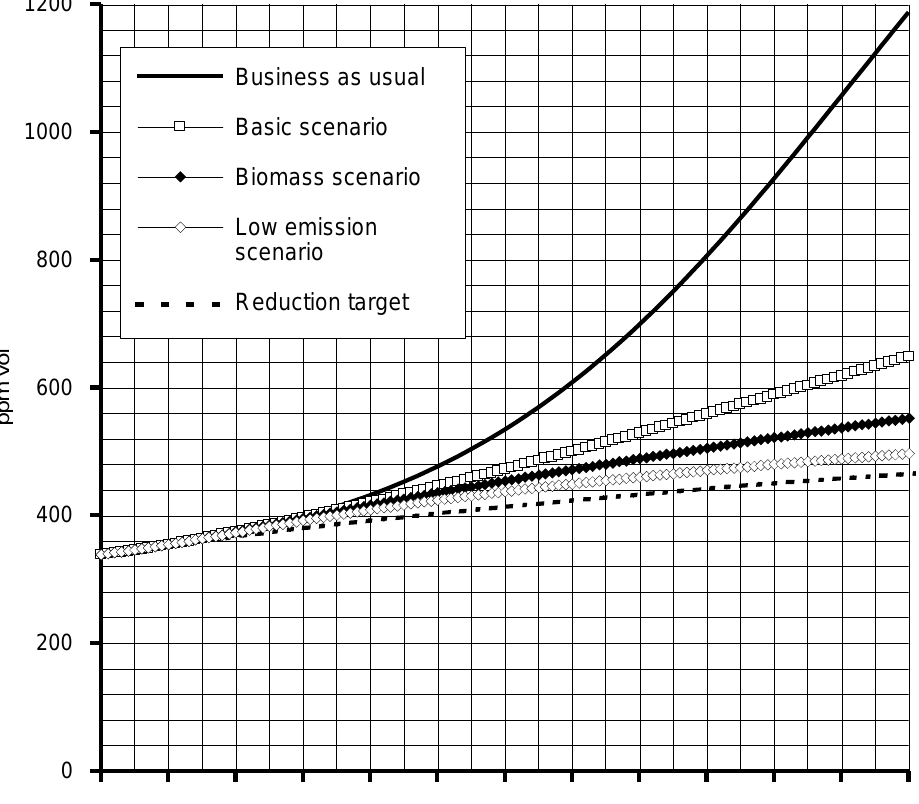
Figure 10. How the assumed (moderate) energy demand until 2100 is covered by single energy car- riers. While overall energy supply is identical in both cases, the energy demand covered by biomass at left is covered by non-carbon sources at right — thus allowing C-neutrality to be assessed.